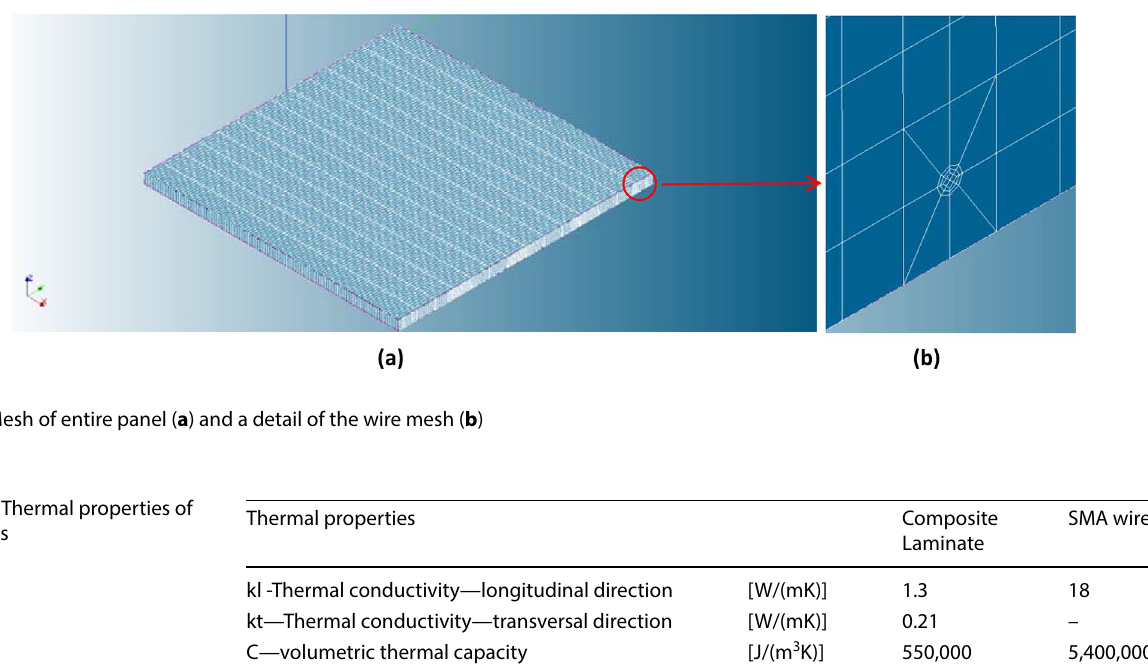
Table 4 Thermal properties of materials